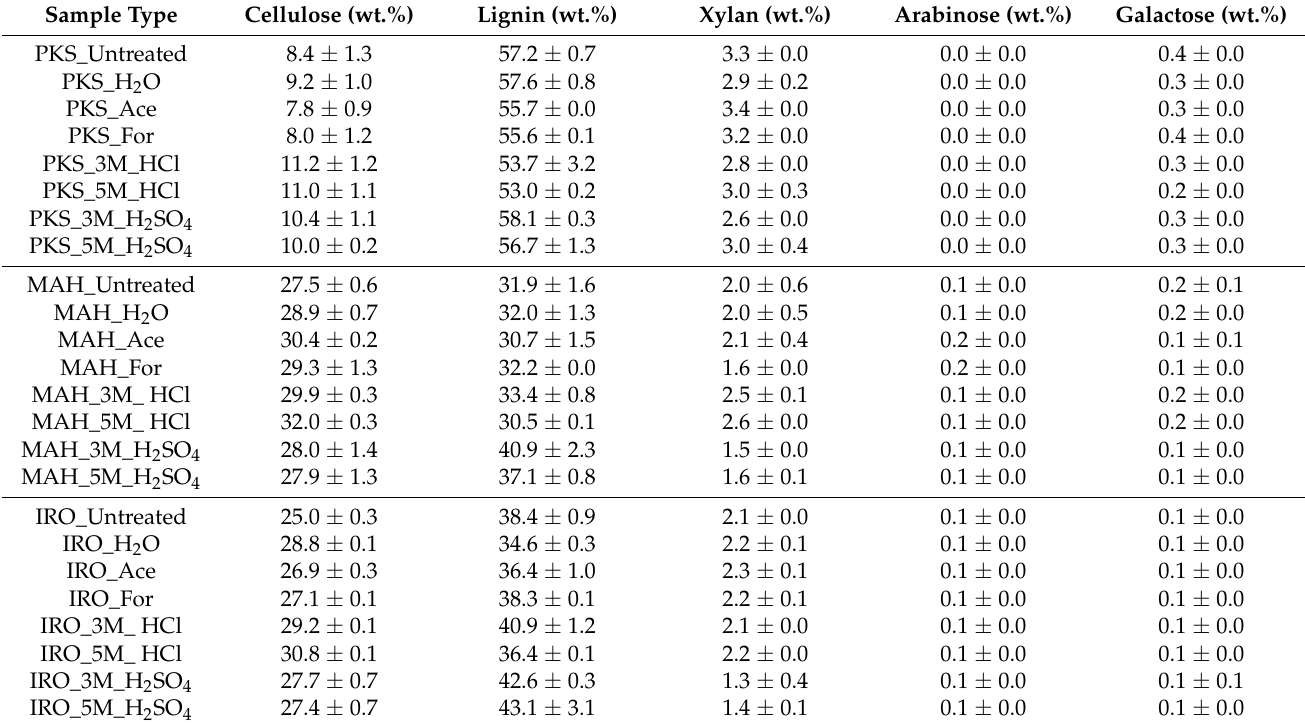
Table 1. Compositional analysis of palm kernel shell (PKS), mahogany (MAH) and iroko (IRO) sawdust.